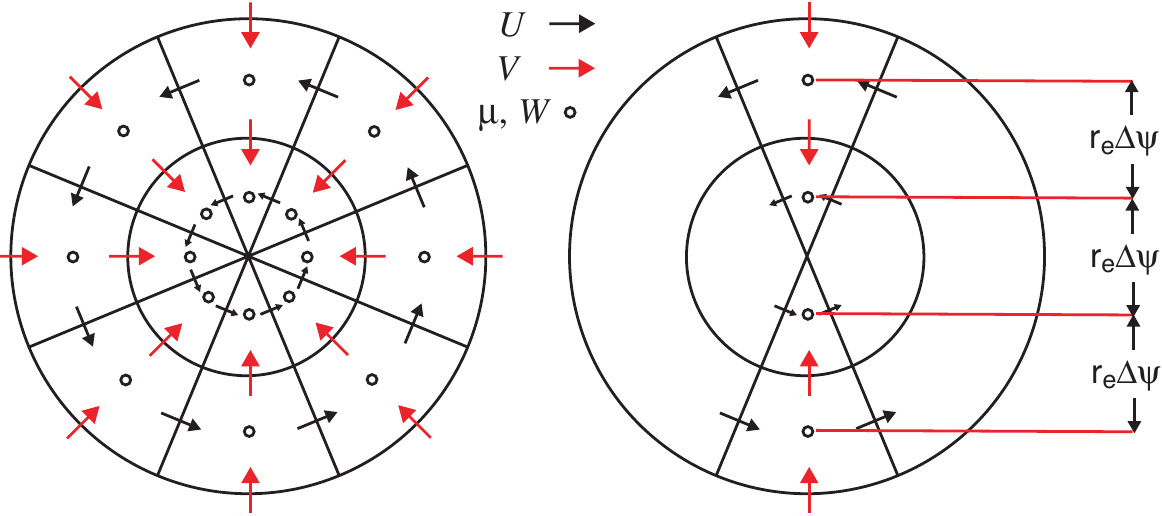
Figure 3.3: Latitude-longitude grid structure in the pole region. In the ARW formulation, r ∆ ψ =∆ y/m e y